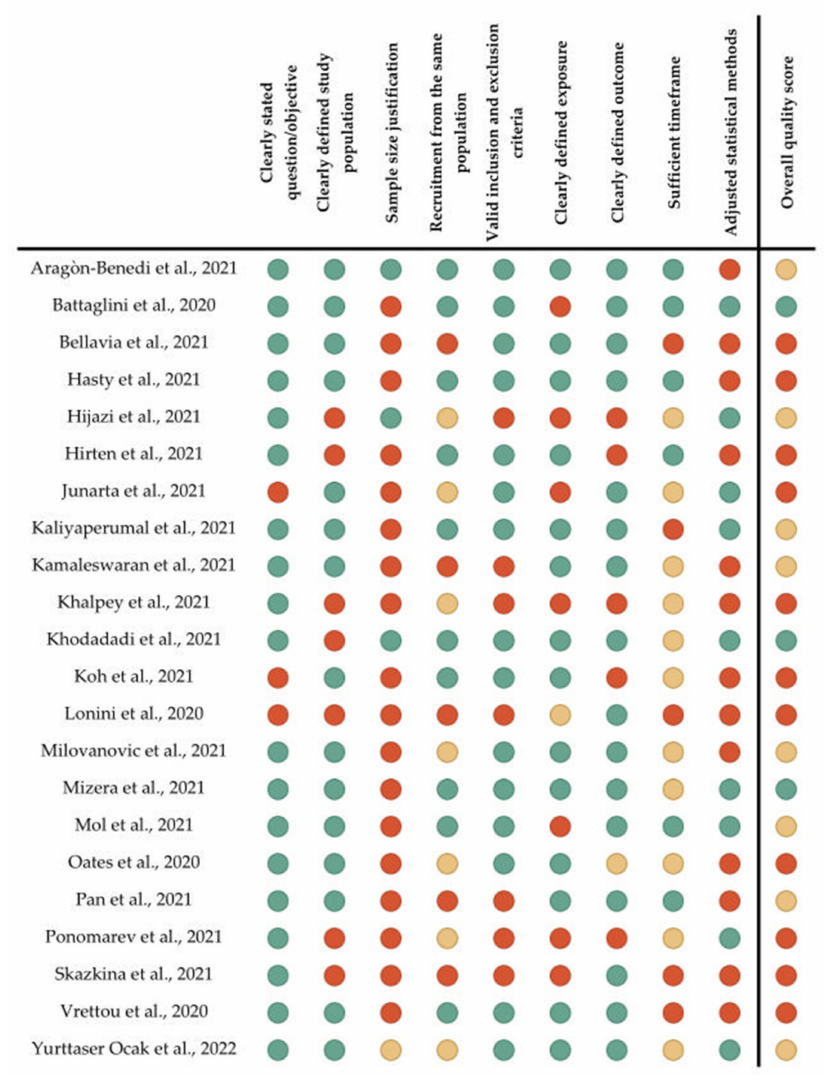
Figure 2. A summary of the quality assessment of the included studies according to the “Study Quality Assessment Tool” issued by the National Heart, Lung, and Blood Institute [29–48,94,95]. Color legend: Green, yes; Yellow, not applicable, not reported, or cannot be determined; Red,